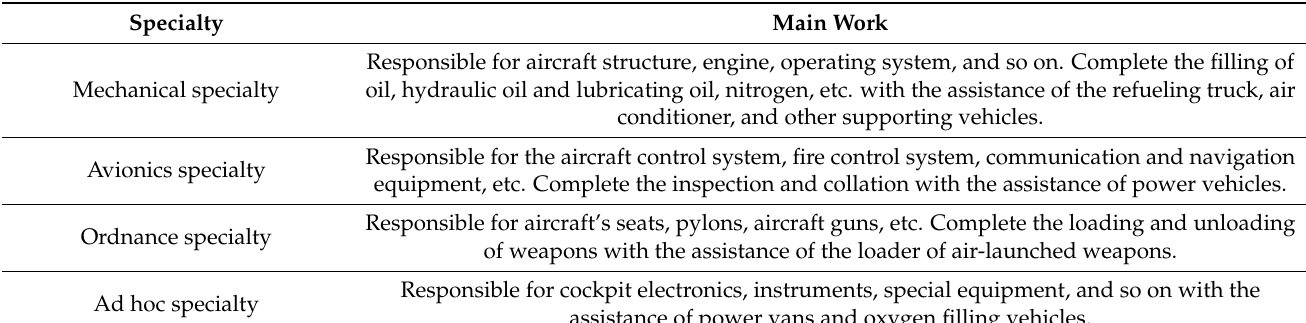
Table 1. The main content of each major of the